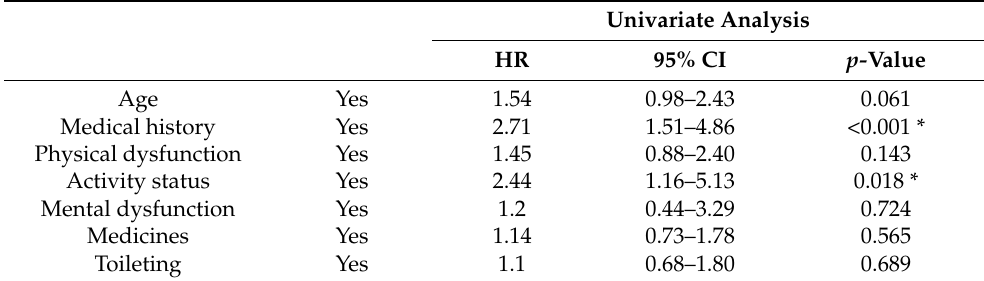
Table 5. Prognostic factors included in FRAS for the overall